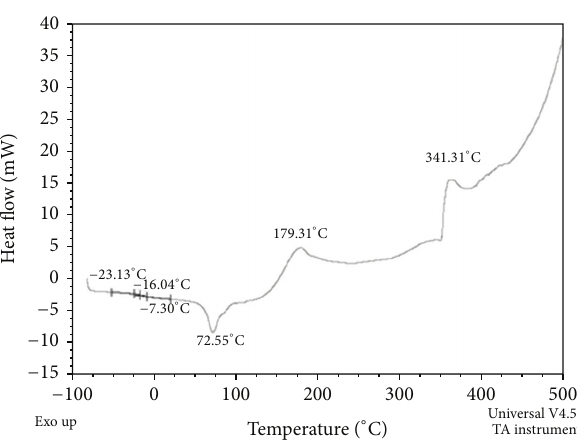
Figure 4: DSC thermogram of polymer